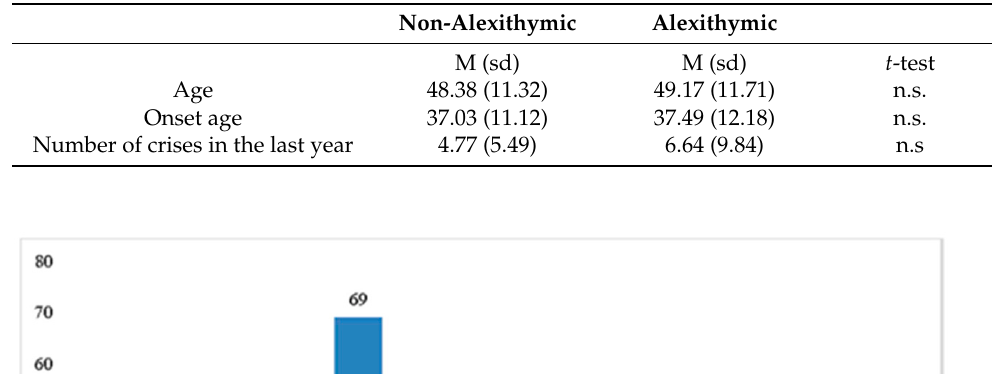
Table 4. Age and Meni è re syndrome’s features comparison between A and NA groups by t -test.